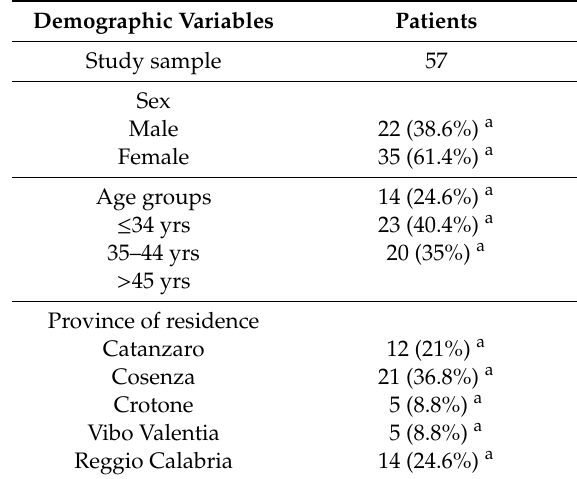
Table 1. Data of the study